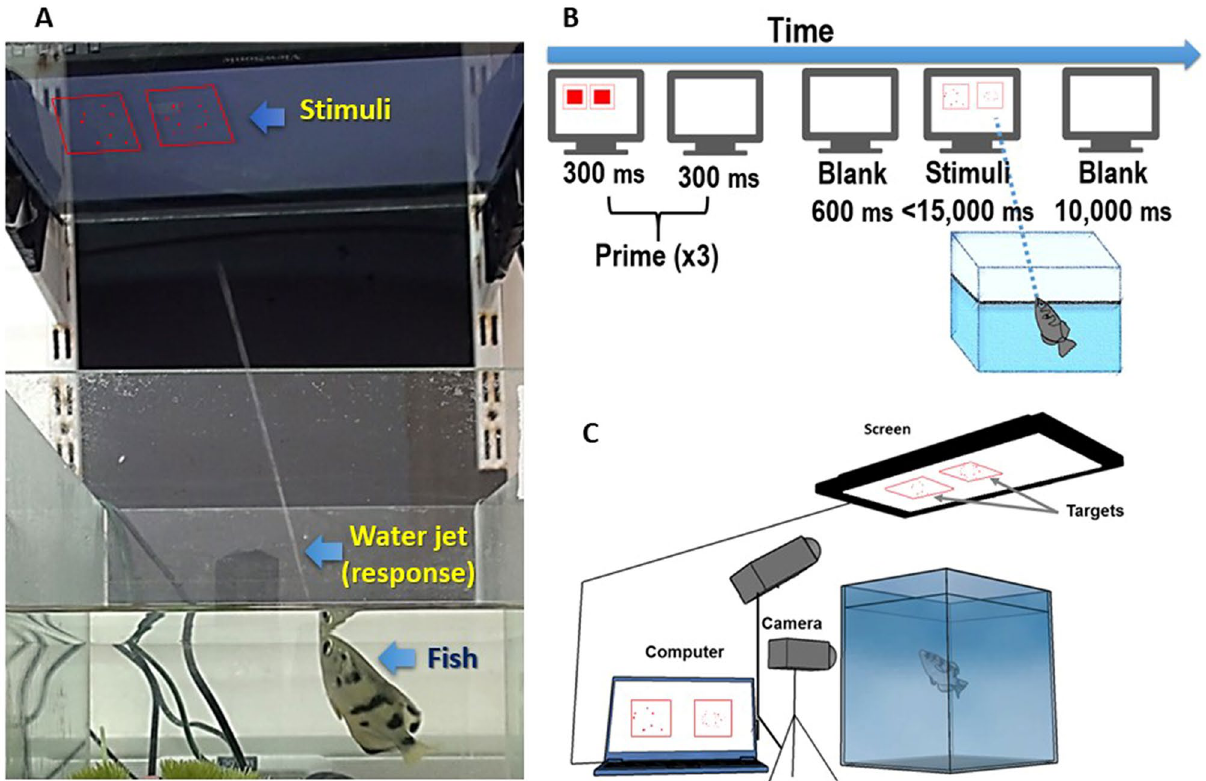
Figure 1. Apparatus and procedure . ( A ) A computer monitor is placed on a glass shelf about 50 cm from the water level. The fish respond by shooting a jet of water at one of the targets. The stimuli in this Figure are illustrations. ( B ) Procedure: a trial starts with three rapid flashes of squares in the fish’s preferred color, to attract the fish’s attention to the location where the targets will appear. Then the stimuli appear until response or until 15,000 ms have passed. Then in a 10,000 ms break, the fish is rewarded with a food pellet for responding, and the water is wiped from the glass. ( C ) The experiment was recorded by two synced high speed (120 Hz) video cameras, one camera records the fish, and the other records the screen. Part ( C ) was modified from Karoubi, Leibovich, and Segev, 2017 25 Response is affected by the level of congruity. One-way ANOVA for every fish (with session num- ber as the random factor) revealed that the proportion of selecting the larger numerical quantity significantly increased with the number of non-numerical magnitudes congruent with numerical quantity in all fish, except for fish 4 (Fig. 2). The same analysis and results were obtained at the group level (i.e., with fish as a random factor). A similar pattern of results was also observed when employing Bayesian statistics, by calculating Bayes Factors (BF) (Table 3). Importantly we found that in congruity levels 1–4 selecting the larger numerical quantity was significantly below chance level, suggesting that fish preferred the group containing larger non-numerical magnitudes over the group containing a larger number of dots. This was true for all fish except fish 1 and 2 that only in congru- ity level 3 selected the larger numerical quantity significantly above chance level (one-tailed one-sample t-test